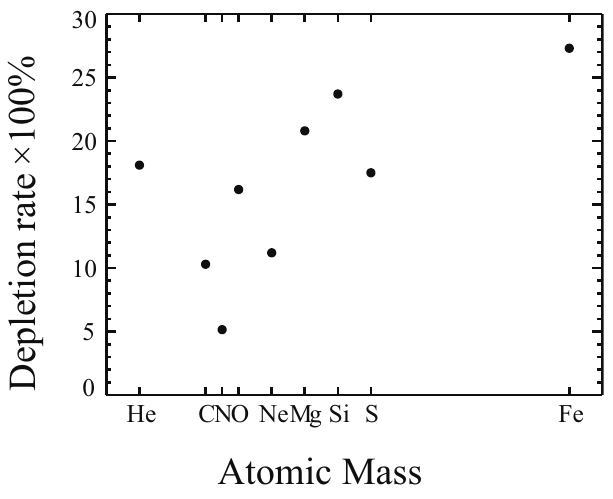
Figure 8. Comparison of the depletion rates with the atomic mass of the